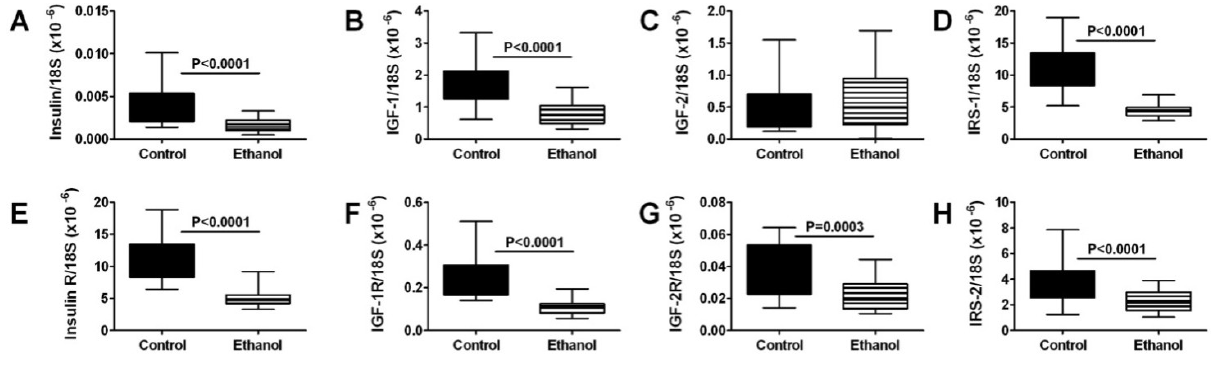
Figure 1. Chronic ethanol feeding impairs insulin/IGF signaling in skeletal muscle. Gastrocnemius muscles from control and chronic ethanol fed rats were used to measure mRNA expression of ( A ) insulin; ( B ) IGF-1; ( C ) IGF-2; ( D ) IRS-1; ( E ) insulin receptor; ( F ) IGF-1 receptor; ( G ) IGF-2 receptor; and ( H ) IRS-2 by qRT-PCR analysis.